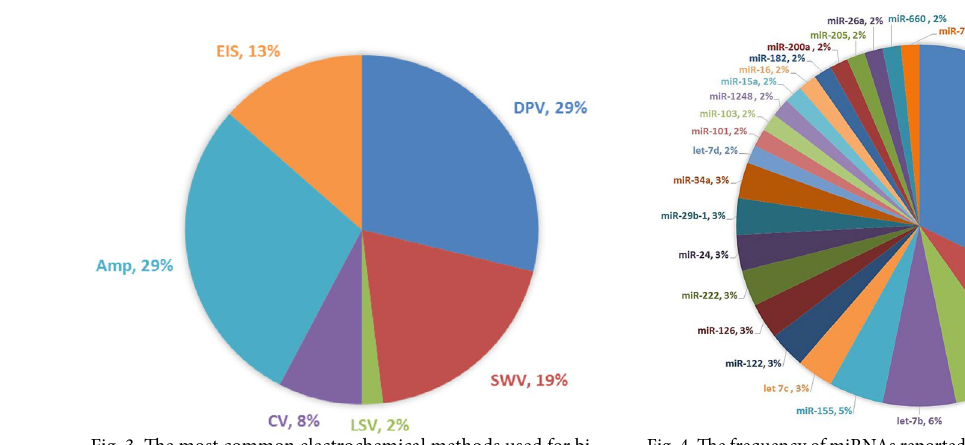
Fig. 3. The most common electrochemical methods used for bi- osensing. Data collected from Web of Science database.